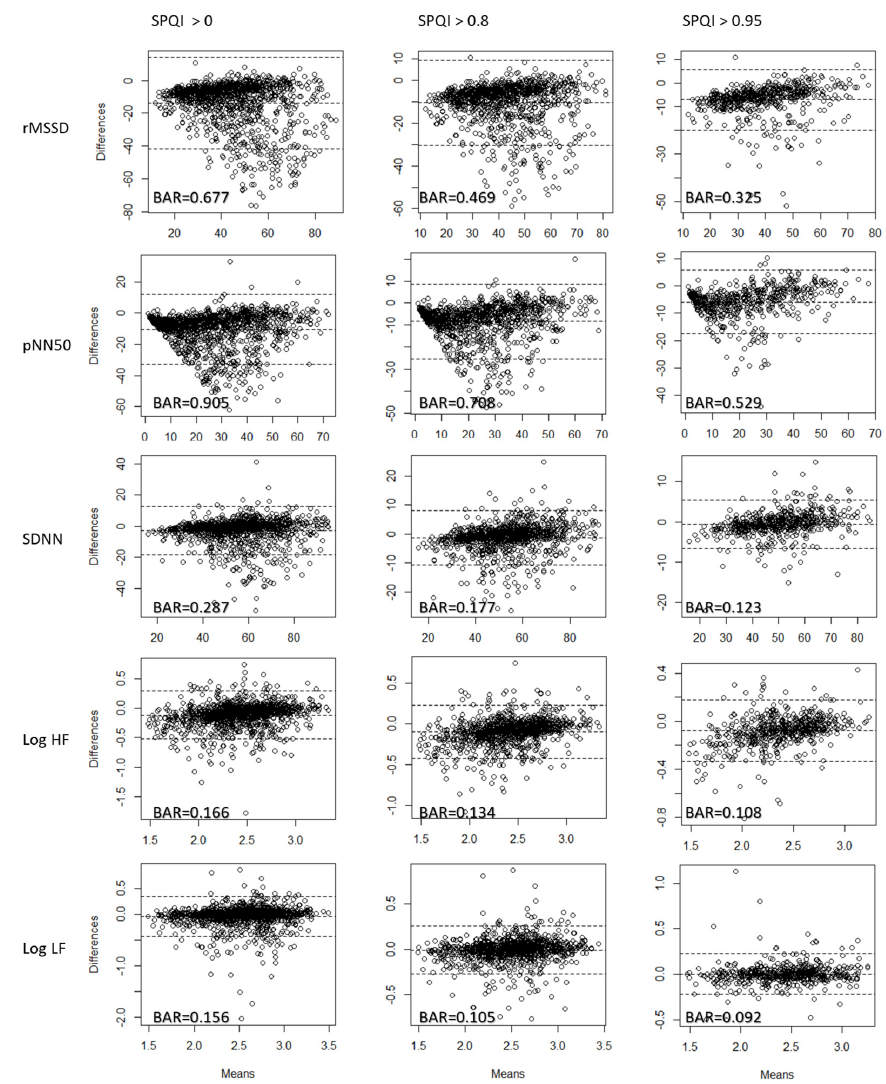
Figure 4. Bland–Altman plot and BAR smartphone PPG (with Tangent) and reference ECG data for each HRV measure.